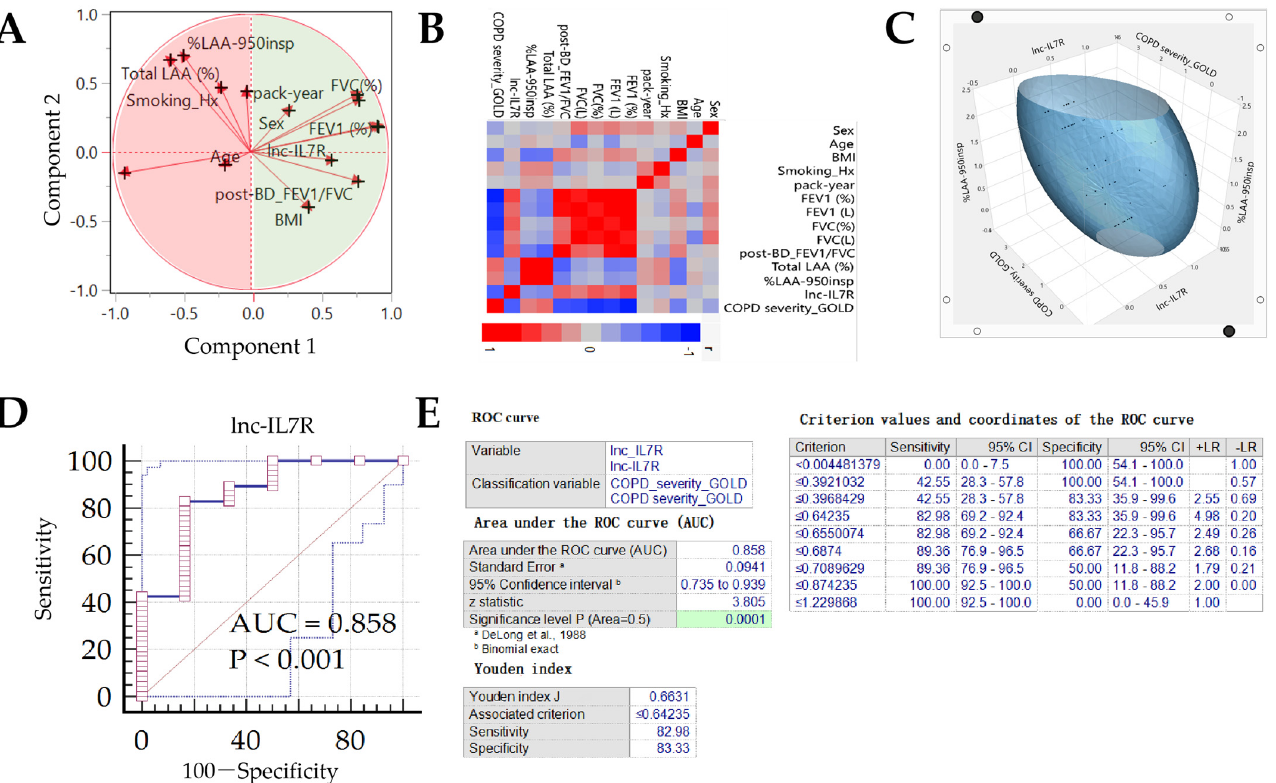
Figure 1. lnc-IL7R positively correlates with physiological pulmonary function and exhibits diagnostic relevance for COPD-based patient stratification. ( A ) Visualization of principal component analysis based on factor analysis loading showing the associative predisposition of our panel of COPD-related variables and their stratification into components 1 and 2. ( B ) Correlative heat map of our panel of COPD-related variables. ( C ) Ellipsoid 3D image of the association between lnc-IL7R , GOLD-defined COPD severity, and %LAA -950insp -based Emphysema severity. ( D ) Graphical depiction of the ROC curve and AUC value of lnc-IL7R expression in our COPD cohort. ( E ) Statistical chart of the ROC curve of lnc-IL7R expression. ROC, receiver operating characteristic; AUC, area under